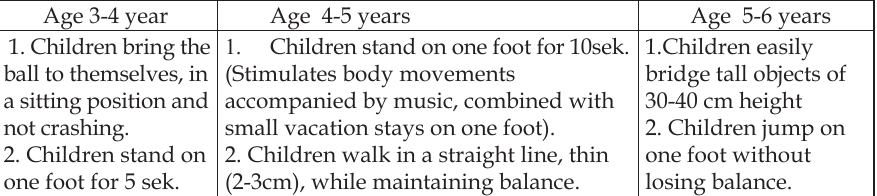
Table 4. Standard 2: Development of equilibrium skills.